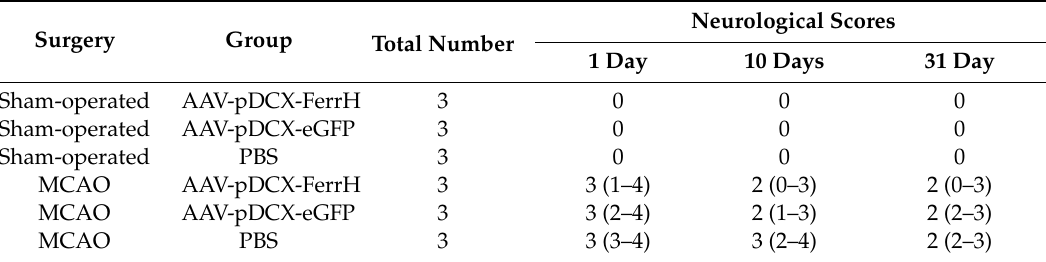
Table 1. Animal neurological scores after surgery 1 .